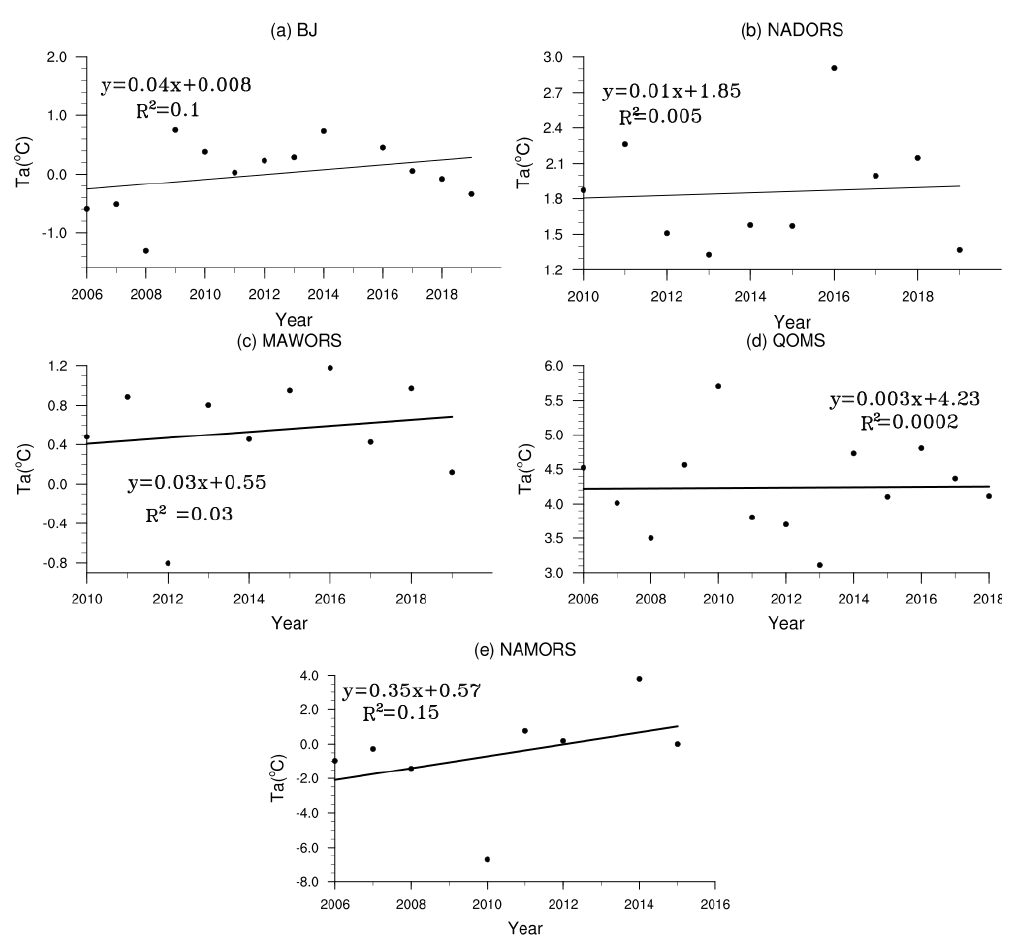
Figure 24. Interannual variation of air temperature at each station.